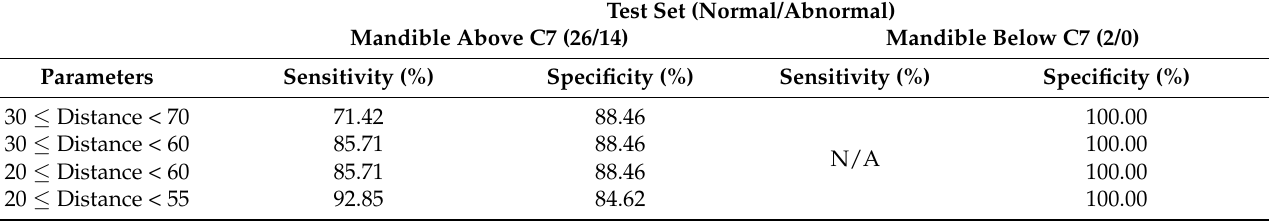
Table 3. Appropriateness prediction based on tube-to-carina and tube-to-clavicle distance ( ≥ 0 mm) using the test dataset. Distances are represented in millimeters (mm).